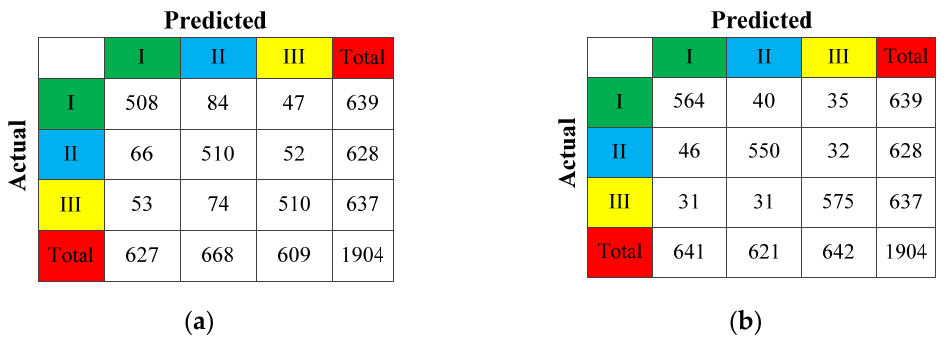
Figure 5. The confusion matrices with training data. ( a ) Scheme A confusion matrix with unreduced attributes. ( b ) Scheme B confusion matrix with reduced attributes.